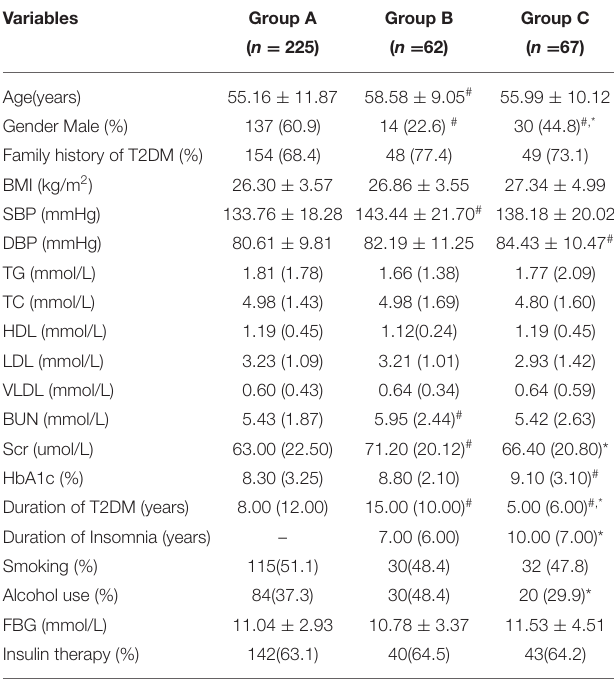
TABLE 1 | Clinical and laboratory characteristics of study participants before propensity score